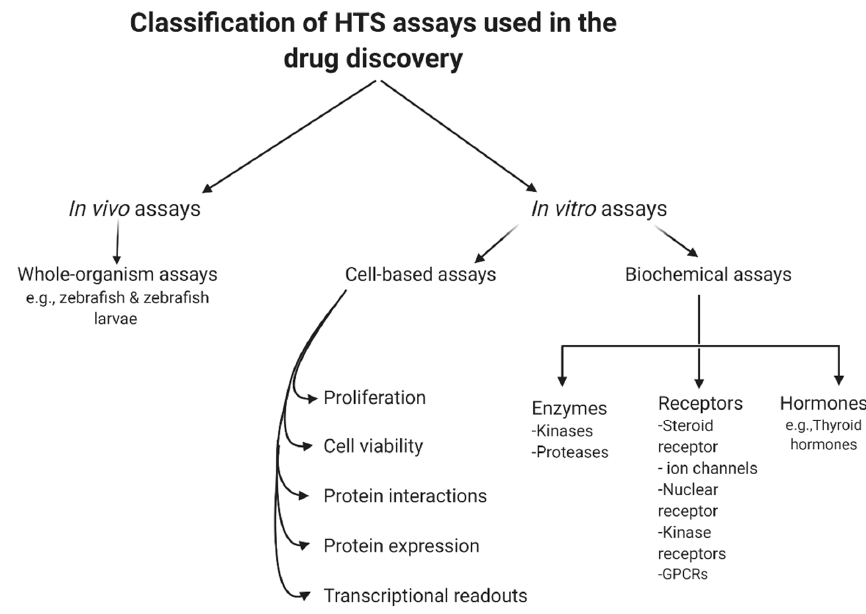
Figure 2. General classification of high-throughput screening (HTS)